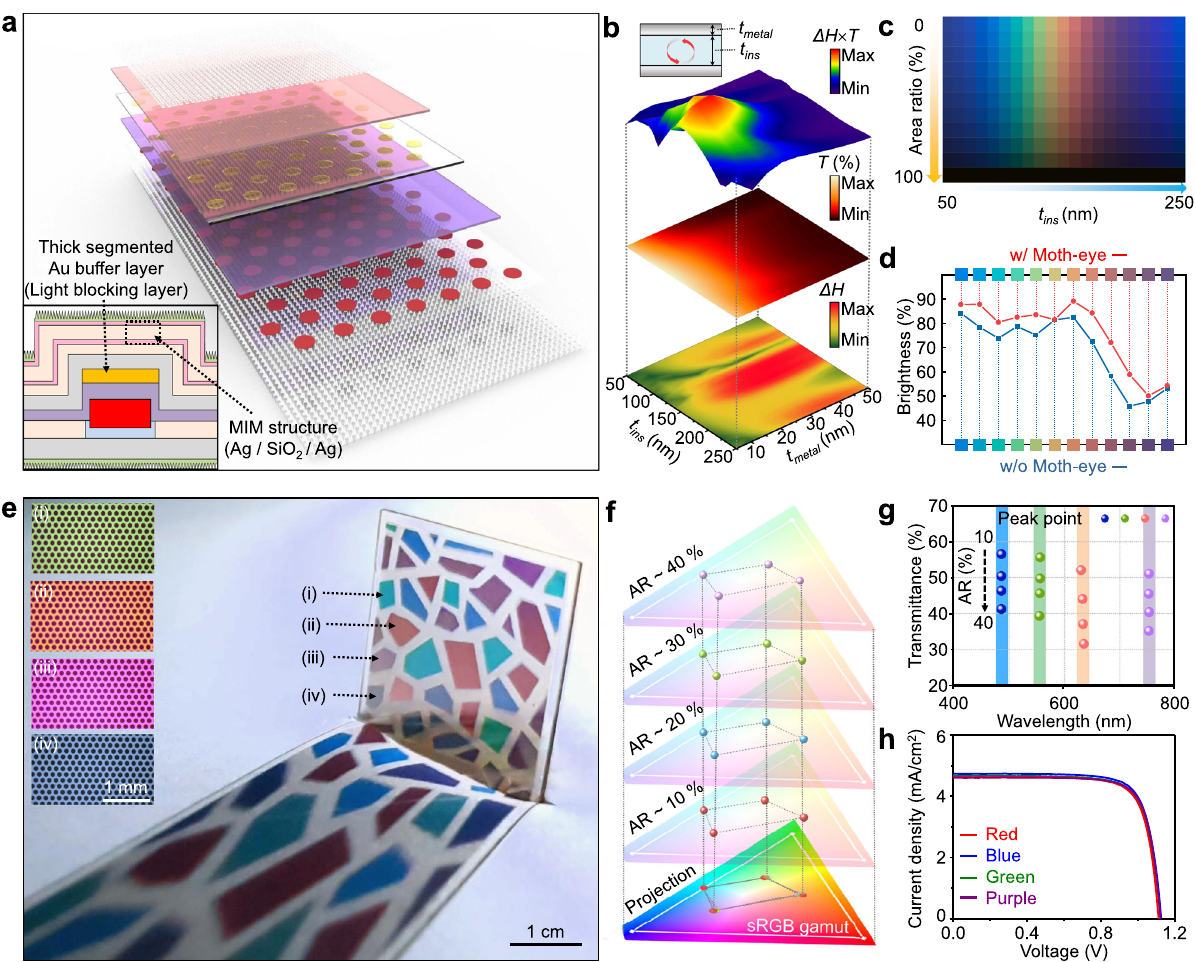
solar window with the metal – insulator – metal (MIM) resonant structure. The inset shows a cross-sectional view of the perovskite microcell in the colored solar window. b Contour plots of color difference ( Δ H ), transmittance ( T ), and product of two values ( Δ H × T ) for optimization of the thicknesses of insulator ( t ins ) and metal ( t metal ). The upper-left inset shows a schematic illustration of the MIM structure. c Color palette for various ARs and t ins . d Chromatic brightness of the colored solar window with and without the moth-eye nanostructures. e Photograph of a mosaic-patterned colored solar window with four different colors (i.e., red, green, blue, and purple). The inset shows optical microscopy images of four PVs ((i) green, (ii) red, (iii)